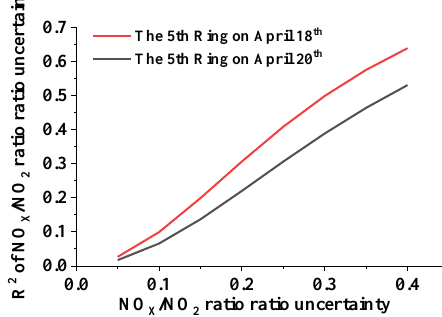
Figure 12. The variation in the R 2 of NO X / NO 2 ratio uncertainty with NO X / NO 2 ratio uncertainty.